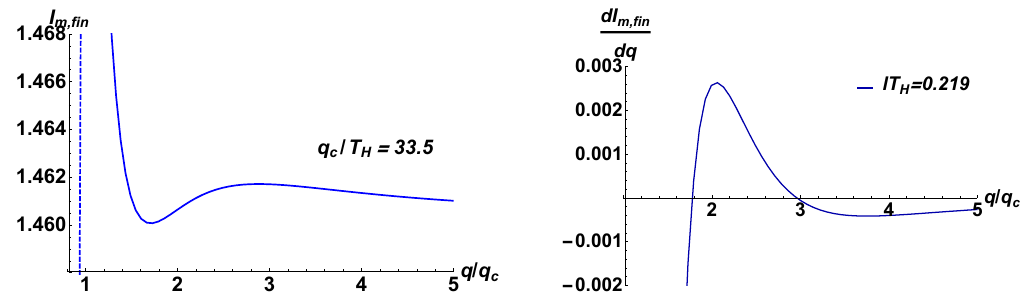
Figure 4 . Typical non-monotonic behavior of I m;fin as a function of q=q c for lT H = 0 : 219 for g 2 = 10 depicted in the left plot. Right: its derivative with respect to charge. One can see clearly YM two zeros: the (cid:12)rst one is minimum at q = 1 : 8 q c , while the second one is maximum at q = 3 q c